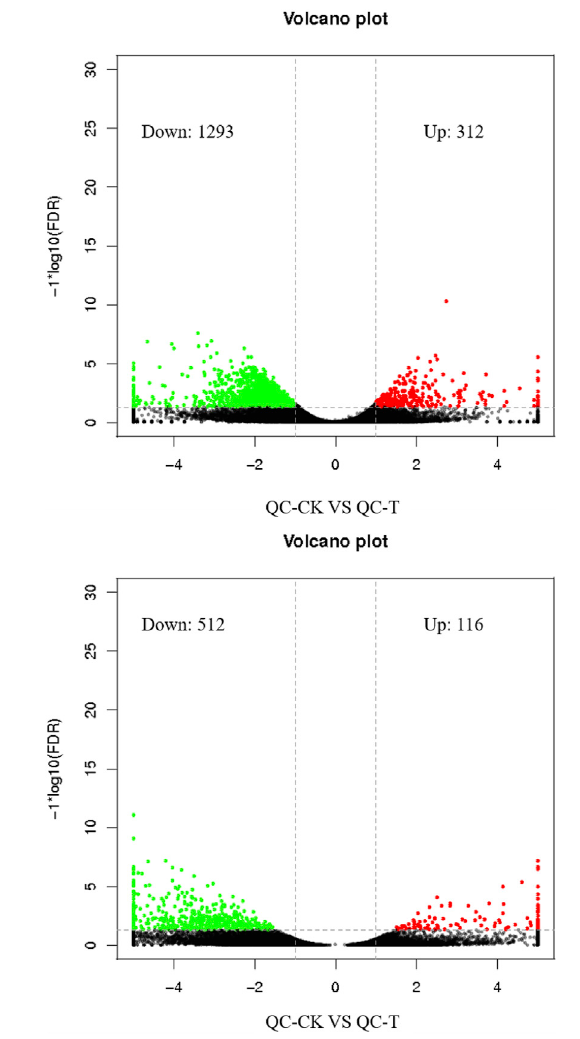
FIGURE 3 | Histogram of differential gene statistics between groups. QC,Cuttingteaplant.ZZ,Seedingteaplant.CK:Cuttingsamplestreatedwith drought for 0 days, T: Cutting samples treated with drought for 20 days.